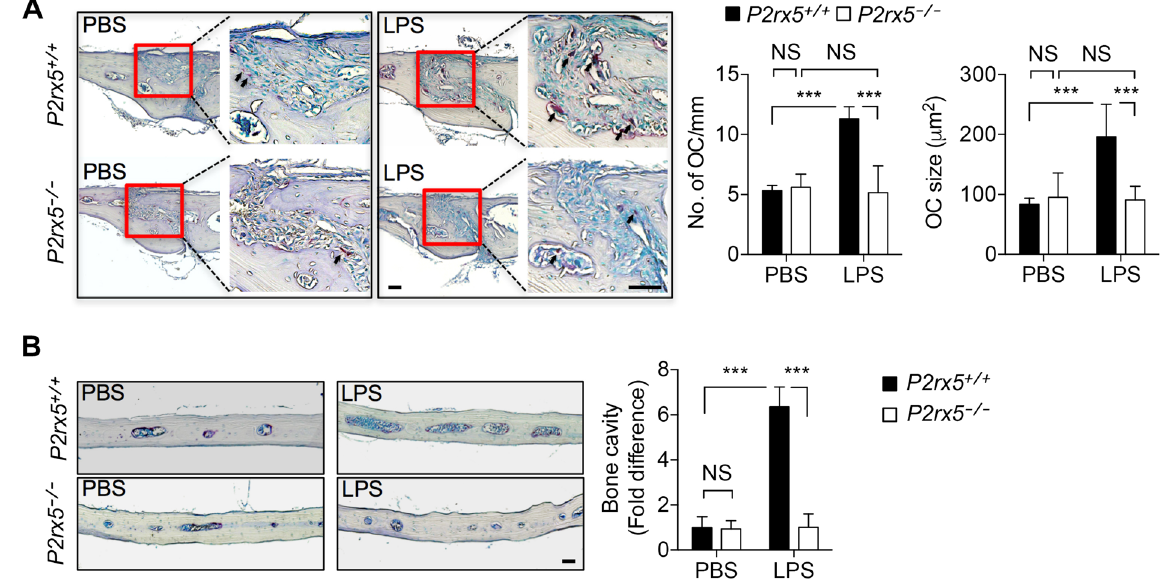
Figure 6. Decreased inflammatory bone loss in P2rx5 − / − mice. ( A ) TRAP staining of histological sections of the sagittal suture, with arrows indicating TRAP + OCs (left panel), and quantitation of the number and mean size (shown as mean OC area) of OCs (right panel). *** P < 0.001. Data are means ± SD. ( B ) Resorption cavities in the parietal calvarium tissue area were measured for PBS- and LPS-treated P2rx5 + / + and P2rx5 − / − mice, and then normalized to the measurement for PBS-treated P2rx5 + / + samples to determine fold differences. Scale bar represents 100 μ m. *** P < 0.001. Data are means ±